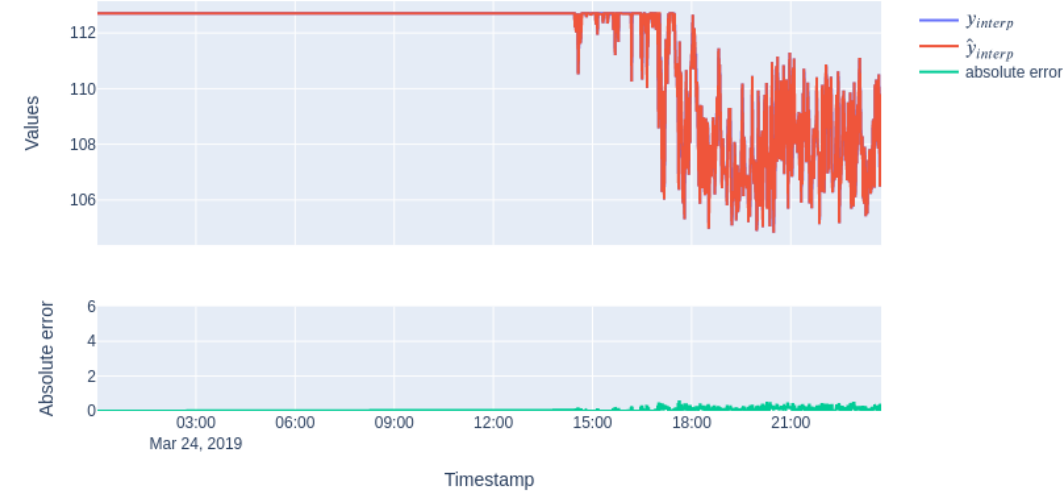
Figure 16. Difference between original data and joined data with desired time sampling frequency 1